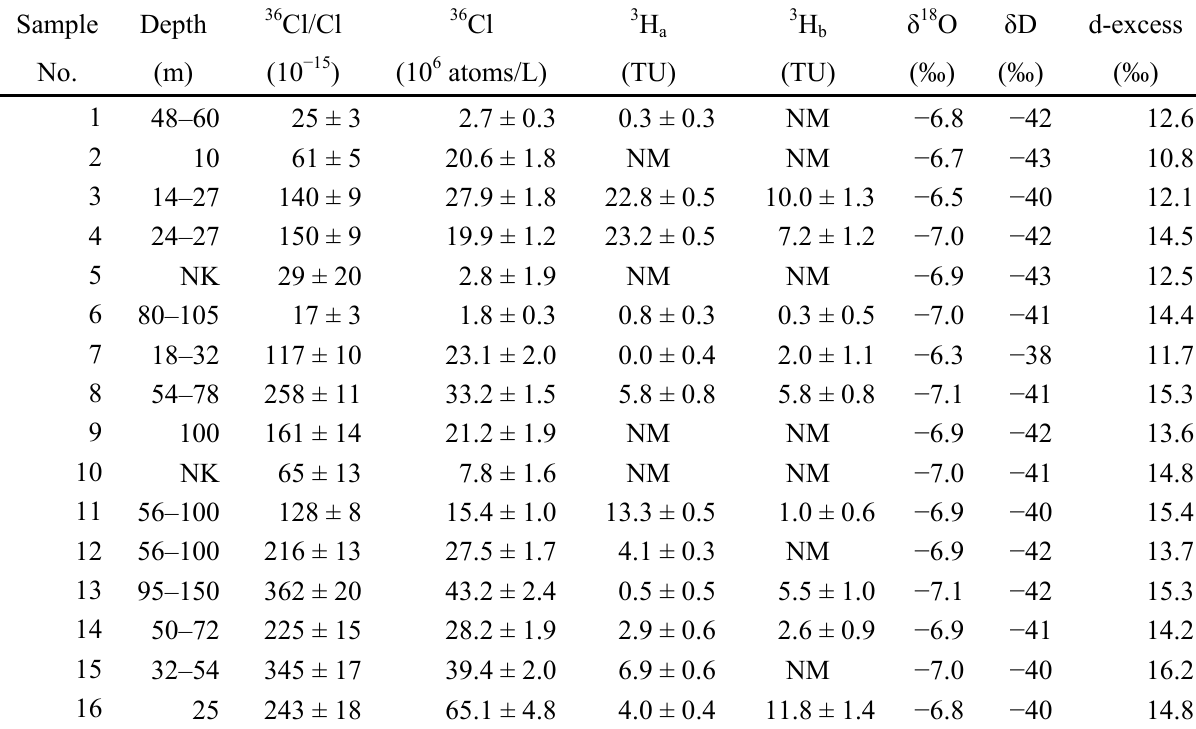
Table 1. 36 Cl and isotopic data for groundwater samples from the Yoro River basin.